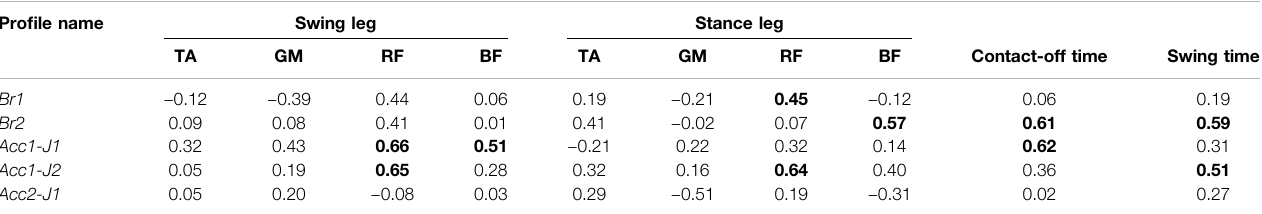
TABLE 10 | Correlations between centre of gravity height and EMG onset latencies, contact-off time and swing time in backward-direction